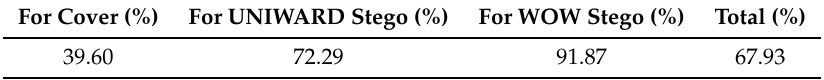
Table 10. Ternary classification rates when changing the activation functions of the proposed CNN ( bpp =